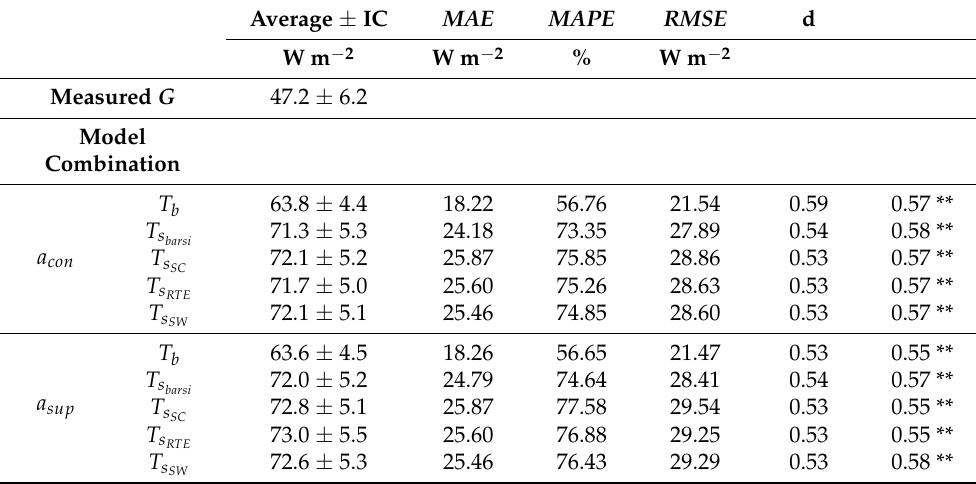
Table 7. Average ( ± 95% confidence interval) of the measured soil heat flux ( G ; W m − 2 ) in the flux towers, and the average ( ± 95% confidence interval), mean absolute error ( MAE ), mean absolute per- cent error ( MAPE ), root mean square error ( RMSE ), Willmott coefficient (d), and Pearson correlation coefficient (r) of the estimated soil heat flux using the conventional ( a con ) and parameterized ( a sup ) surface albedo models combined with brightness temperature ( T b ) and surface temperature corrected by the Barsi model ( T s ), the single-channel model ( T s ), the radiative transfer equation model SC barsi ( T s ), and the split-window model ( T s ). Values with (**) indicate p -value < 0.01. RTE SW Average ± IC MAE MAPE